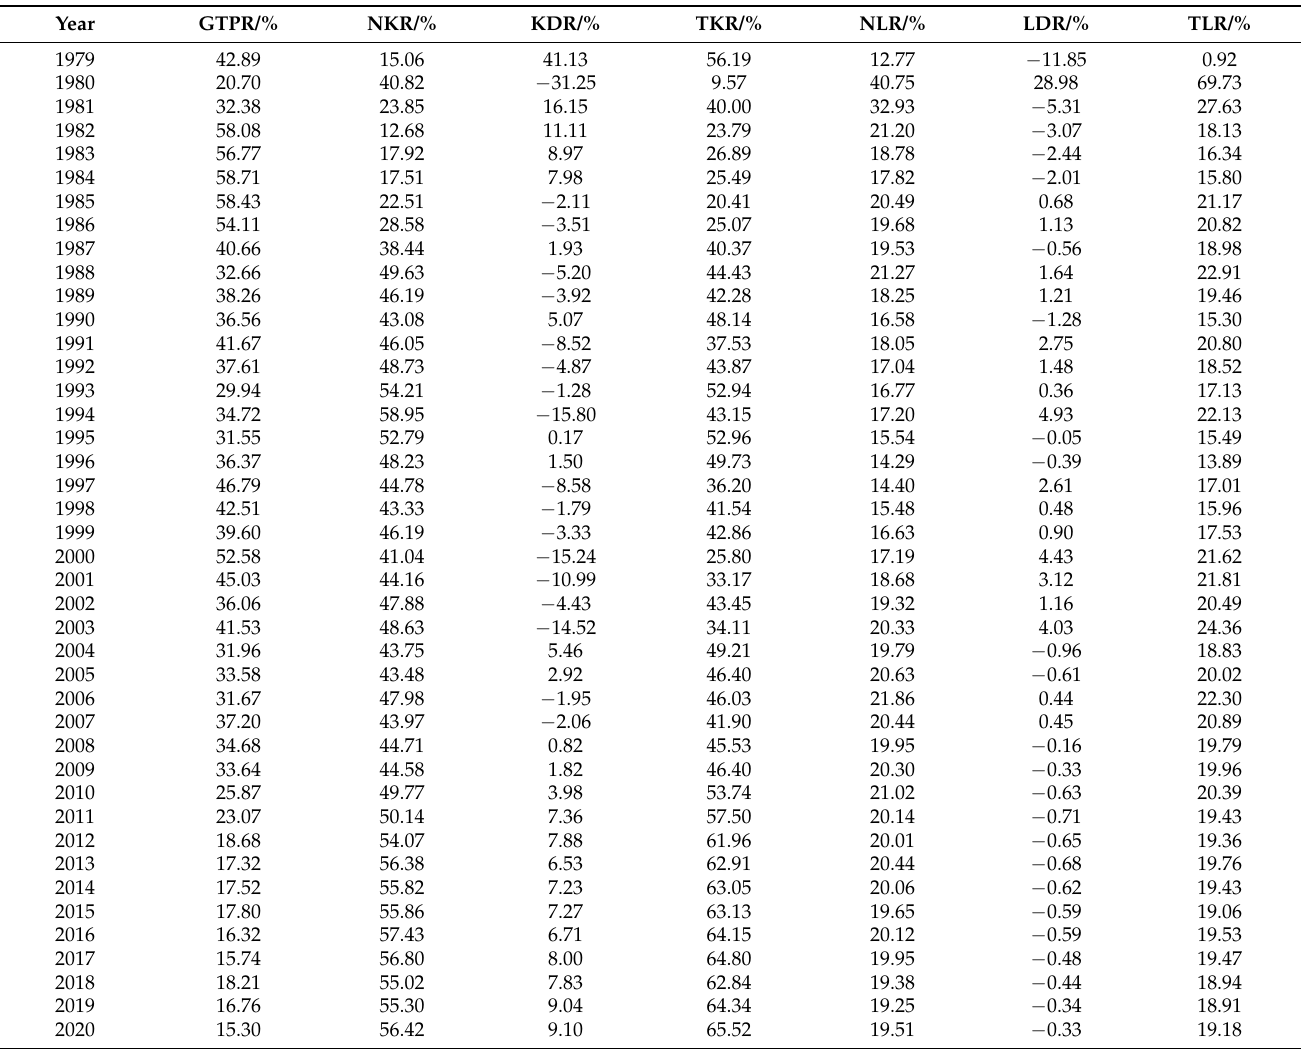
Table A2. Input factor contribution rates in rice yield growth from 1979 to 2020.